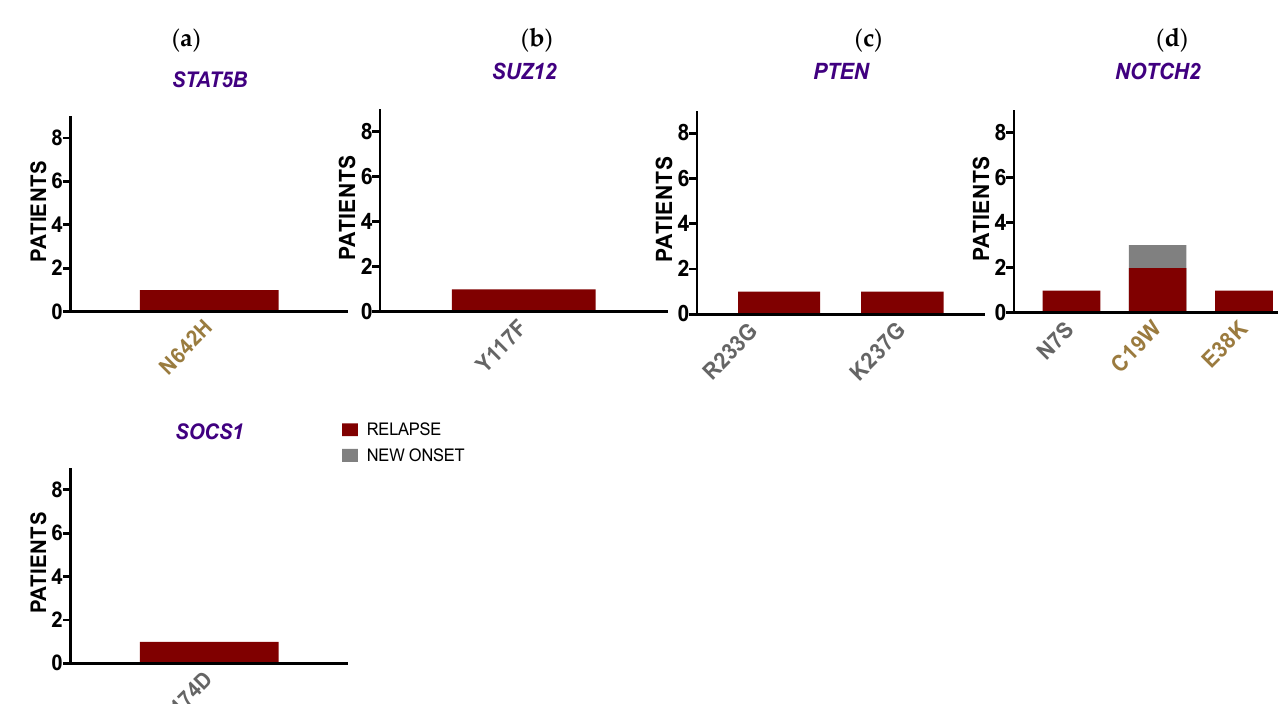
Figure 3. ALL borderland patients harbor tier mutations detected in third-level biomarkers with diagnostic value for leukemia. ALL mutations occur in ( a ) JAK/STAT, ( b ) epigenetic, ( c ) PI3K, and ( d ) NOTCH2 signaling genes that are used as biomarkers for the diagnosis of leukemias and other hematopoietic malignancies. Tier 3 (gold) and Tier X (grey) mutations are shown occurring in new-onset (grey) and relapse (maroon) ALL patients (superimposed bars) within Level 3 clinically relevant genes (purple).